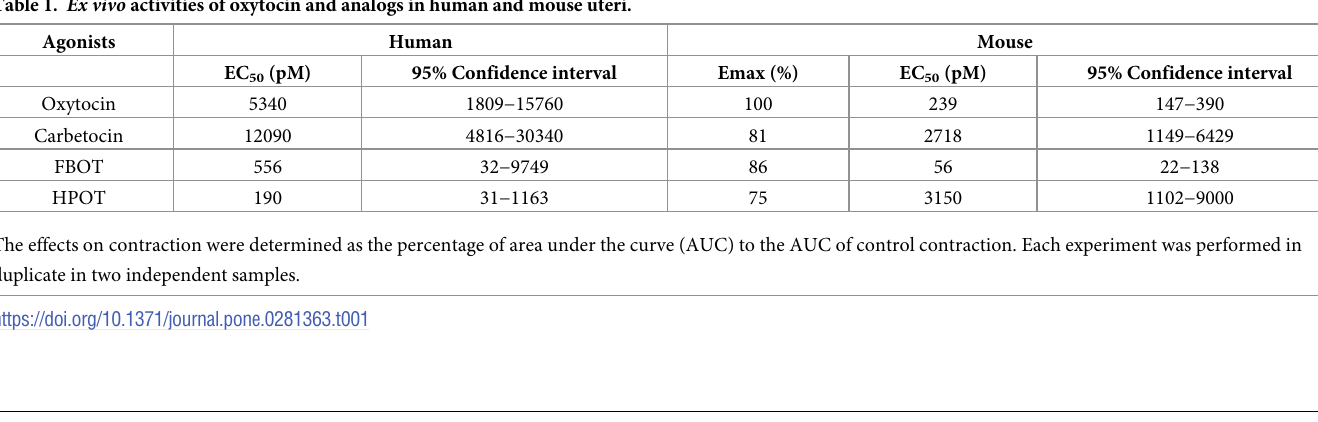
Table 1. Ex vivo activities of oxytocin and analogs in human and mouse uteri. Agonists Human